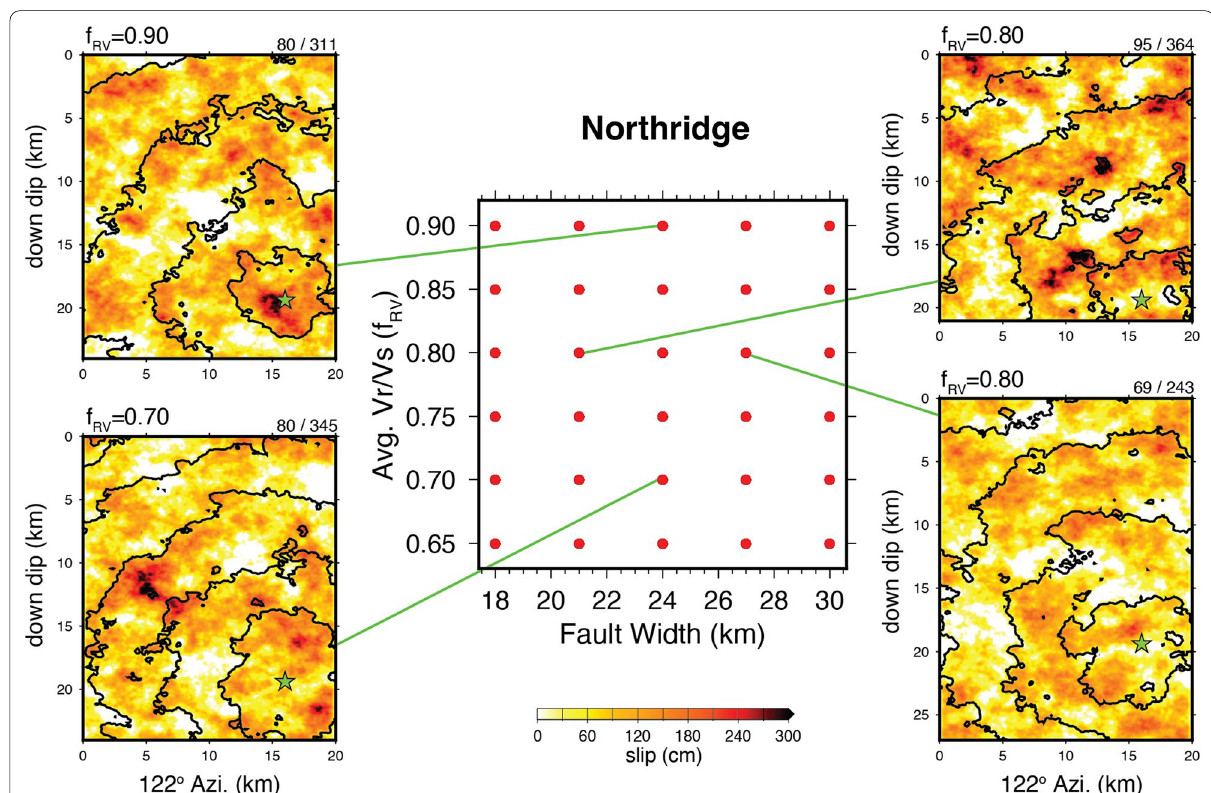
Fig. 3 Examples of Northridge earthquake rupture models. Center panel shows grid of 30 discrete rupture velocity factor ( f RV ) and fault width combinations (red circles) used to generate the kinematic ruptures. For each pair of f RV and fault width, a unique rupture with random slip distribution is generated. Left and right panels show sample ruptures for different combinations of f RV and fault width. For each rupture model plot the green star is the hypocenter, the color shading denotes slip amount with numbers at upper right indicating the average and maximum slip levels, and the black lines show rupture time contours at 1-s